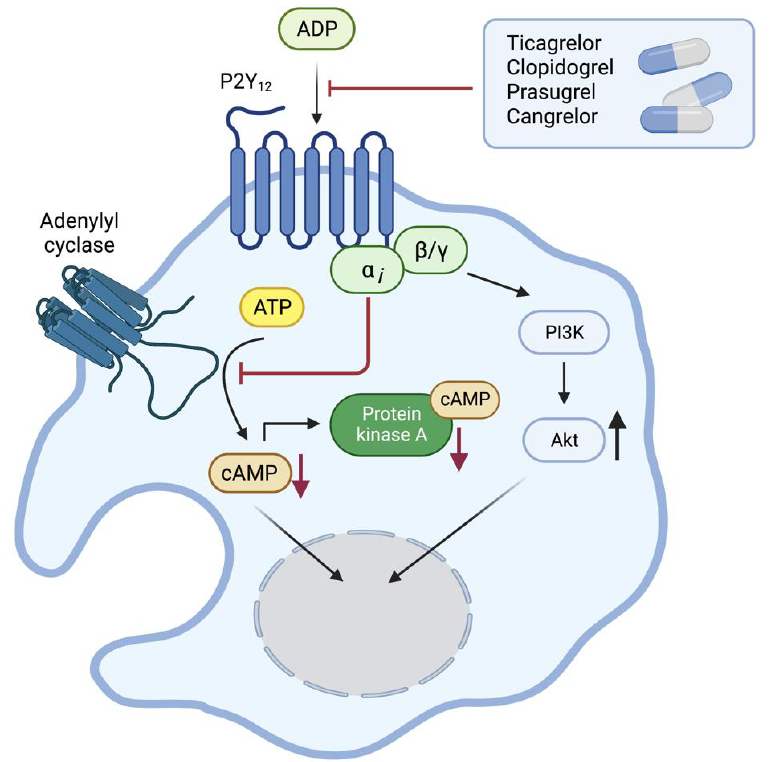
Figure 1. ADP-induced P2Y 12 downstream signaling. ADP binds to and activates the ADP receptor P2Y 12 leading to the inhibition of adenylate cyclases, a decrease in cAMP, PI3 kinase activation, and an increase in AKT phosphorylation. This signaling pathway eventually leads to platelet activation and aggregation. This figure has been generated using the software Biorender (https://www.bioren- der.com).